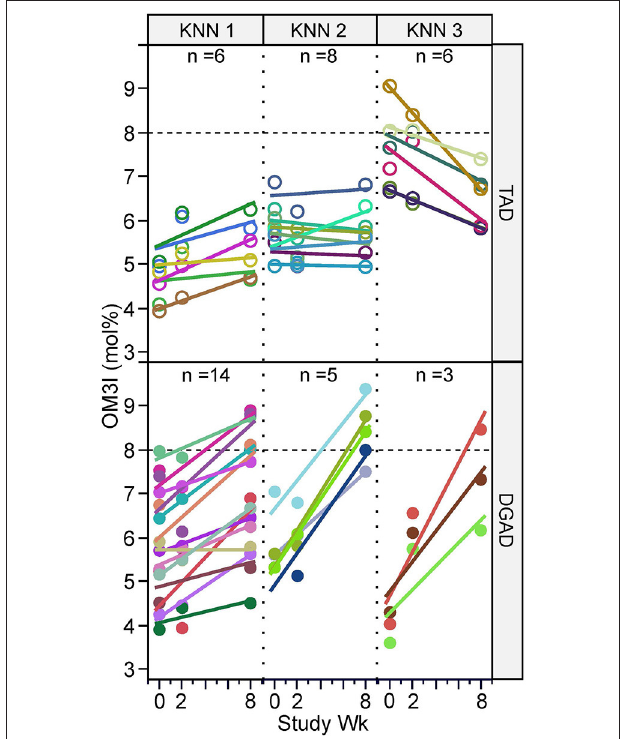
FIGURE 2 | Omega-3 index response rate variance by diet group and time. Participants within the typical American diet (TAD; n = 20) and Dietary Guidelines for Americans diet (DGAD; n = 22) groups were clustered based on the 0–8 wk rate of OM3I change and the average OM3I (Wk0) and OM3I (Wk2) , by K-means clustering, with each diet group being segregated into three groups of participants with different responses. As a significant change between Wk0 and Wk2 was not detected ( Table 3 ), this term was applied to provide a better estimate of the baseline OM3I for this analysis and particularly stabilized the TAD-group clustering. Participant measures and regression lines share common colors.